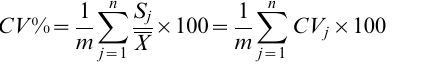
Table 1. Nine populations of K. thoroldiana .